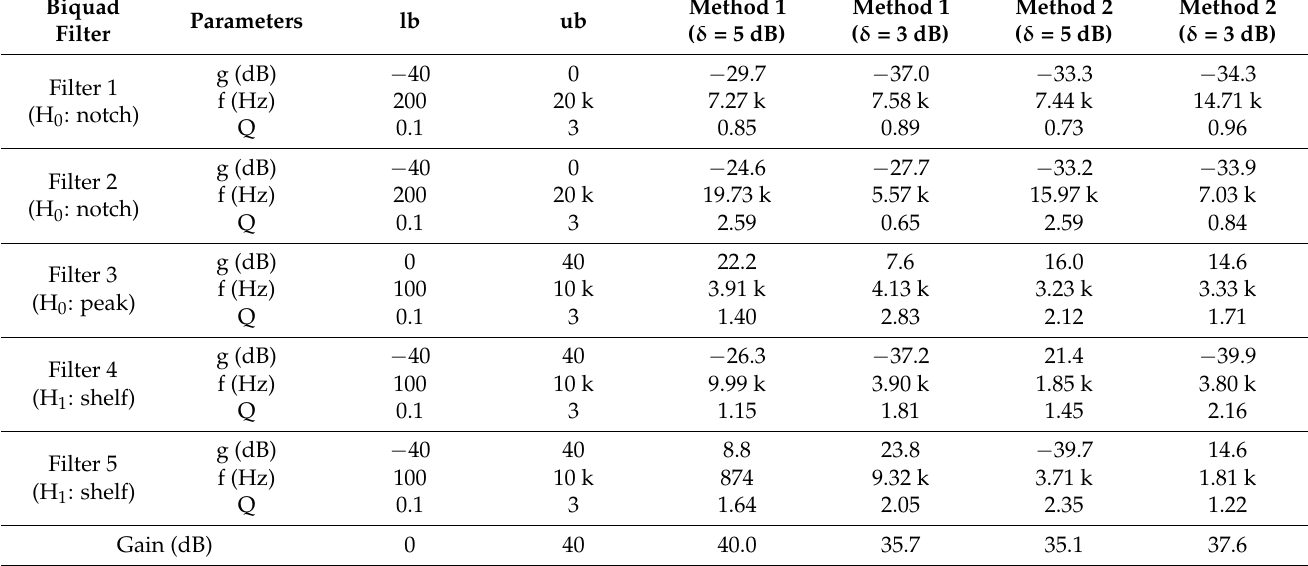
Table 1. Bounds and design results for the parameter vector with different